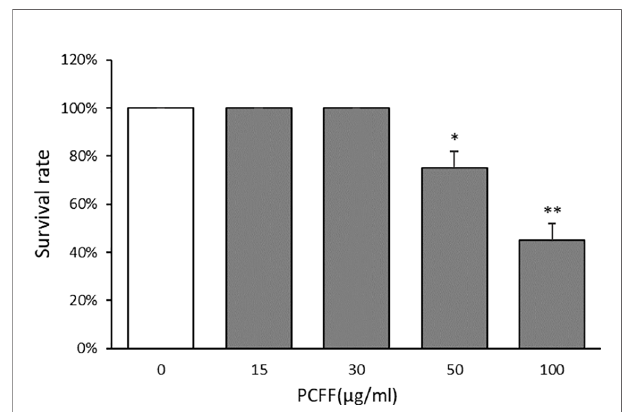
FIGURE 2 | Survival rate of zebra fi sh. Each value indicates the mean ± SD from three independent experiments. Compared with normal group, *P < 0.05, **P < 0.01.